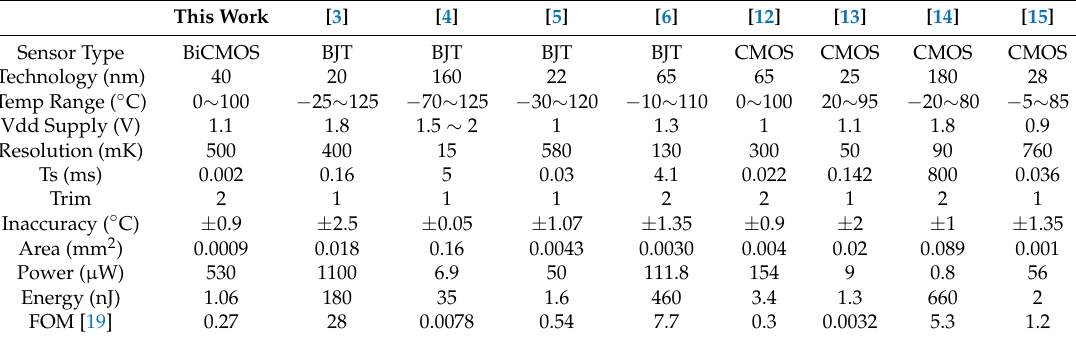
Table 1. Comparison with other voltage monitors described in the